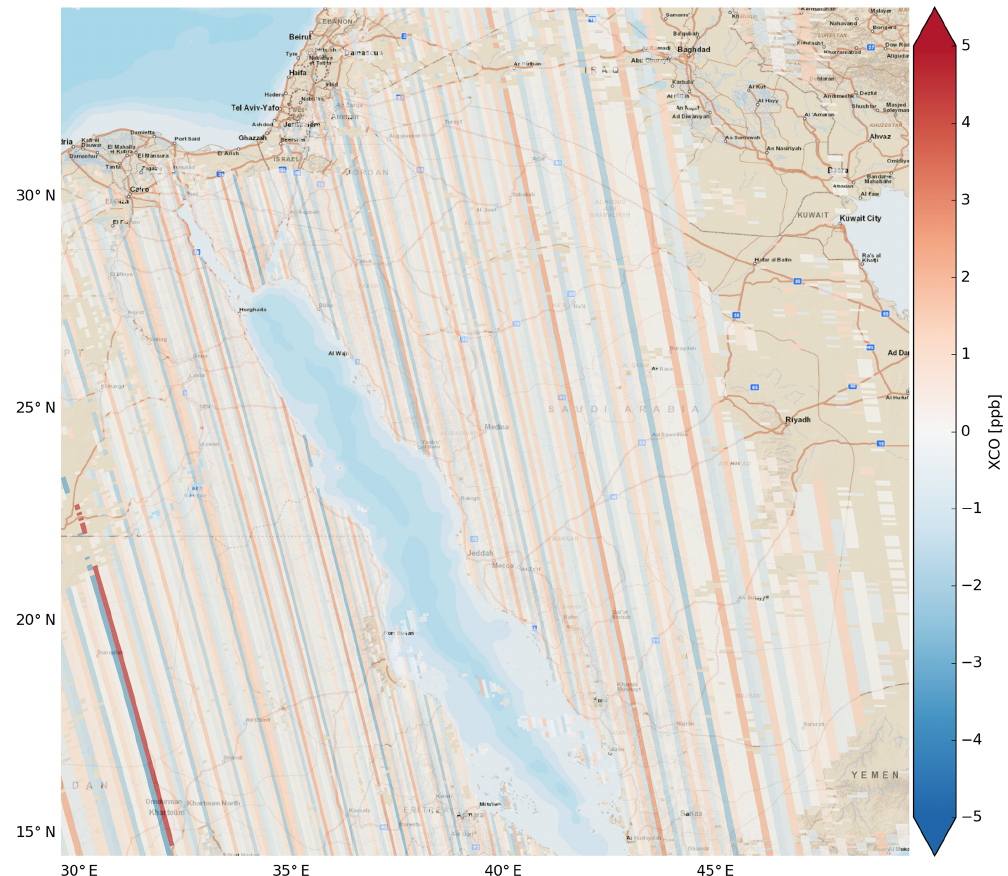
Figure 2. Stripe pattern derived by median filtering from a TROPOMI CO orbit above Saudi Arabia and Egypt on 12 November 2017.